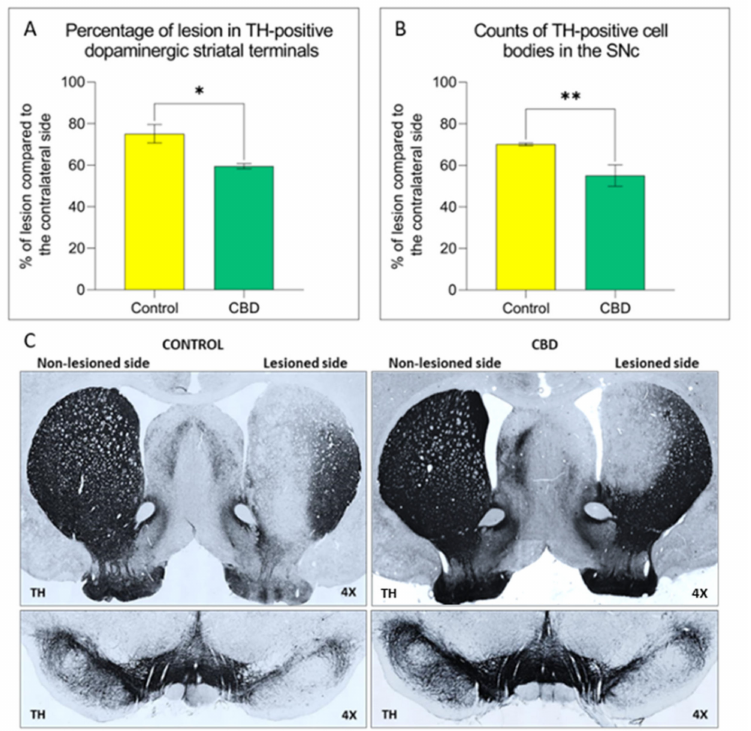
Figure 1. Effect of CBD treatment on the neurodegenerative process in the nigrostriatal pathway. The graphs show the percentage of lesion of ( A ) in the striatum. ( B ) in the SNc. ( C ) Representative images of the nigrostriatal damage in both experimental groups. Results are expressed as mean ± SEM. * p < 0.05 vs. control t = 2947, df = 12. ** p < 0.01 vs. control t = 3102, df = 13, Student’s t -test unpaired two-tailed. N = 6 to 8 in each group.